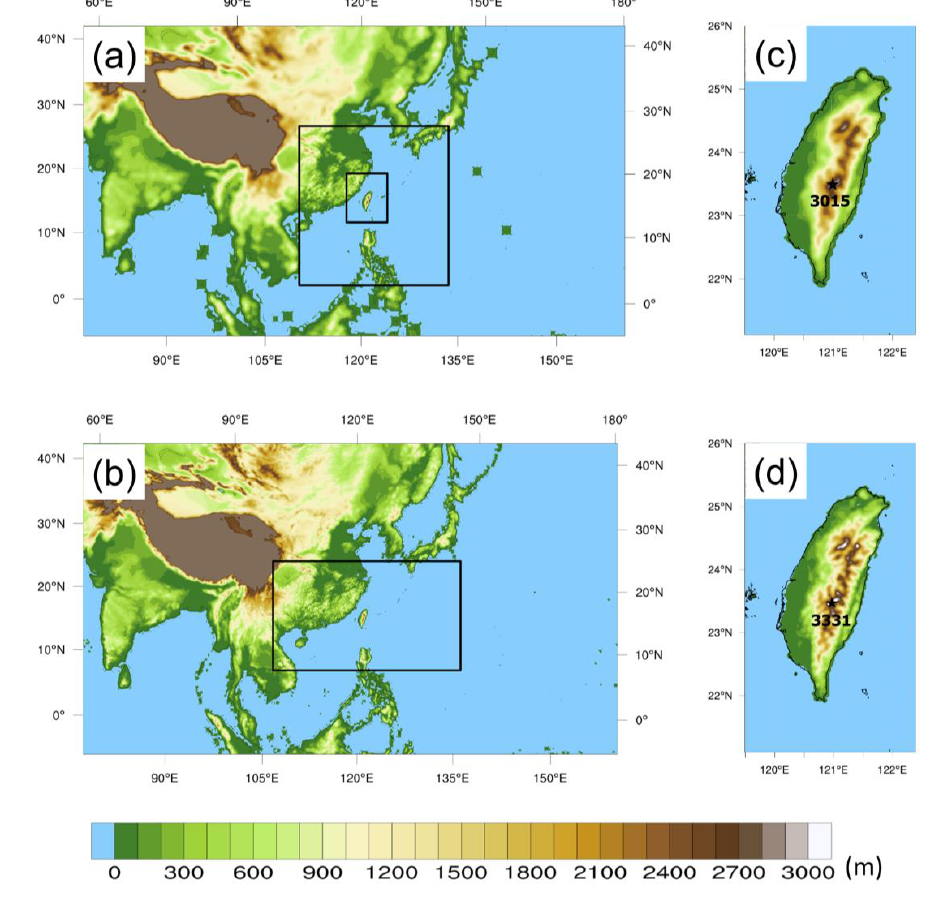
Figure 1. ( a ) Domains of the three-nested grids in the TWRF V1 version. The resolution is 45 / 15 / 5 km for the three grids; ( b ) Domains of the two-nested grids in the TWRF V2 version. The resolution is 15 km for the outer grid and 3 km for the inner grid, respectively. ( c , d ) display the terrain height with resolutions in the inner-most domain of V1 and V2, respectively. The digital numbers in ( c , d ) denote the maximum terrain height which occurred at the position marked as a star sign. Table 1. The designation using di ff erent TWRF versions (V) and resolutions in each domain